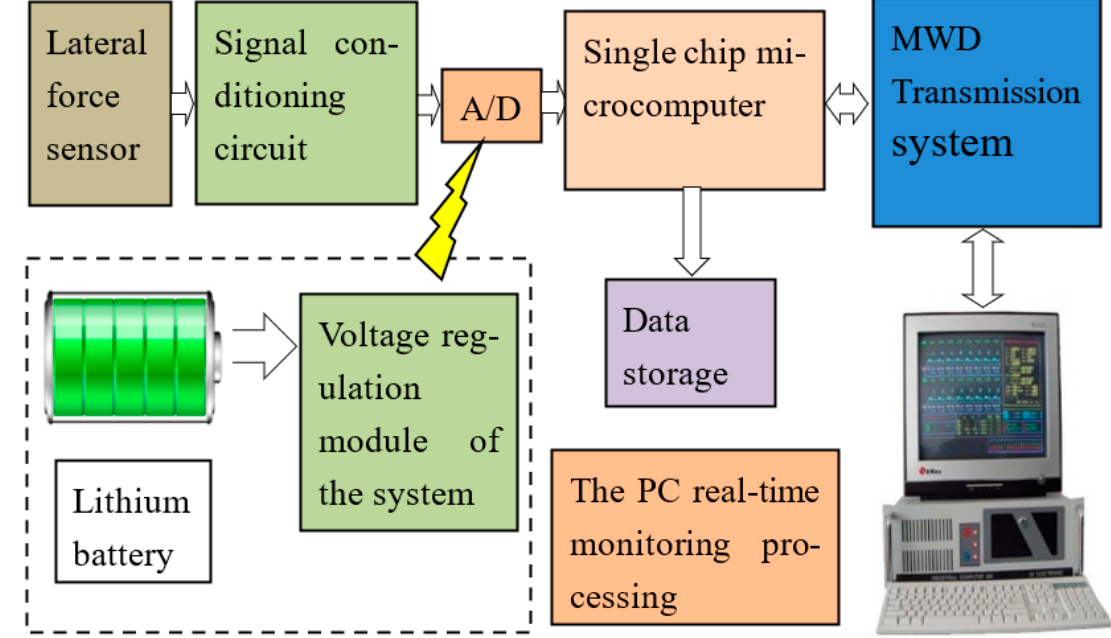
Figure 8. Total block diagram of measurement